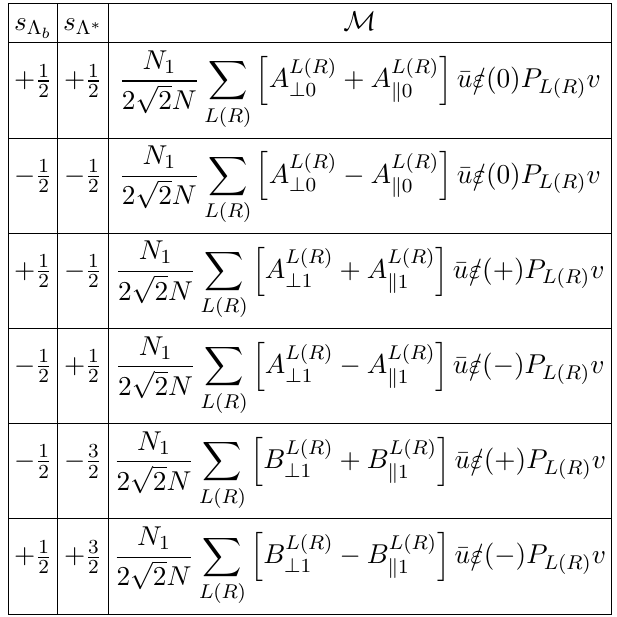
Table 1 . (cid:3) b ! (cid:3) (cid:3) ‘ + ‘ (cid:0) decay amplitudes in terms of hadronic transversity amplitudes.